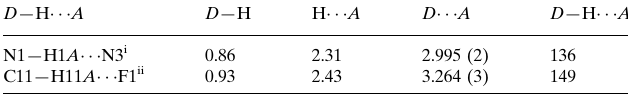
Hydrogen-bond geometry (A˚ , (cid:1)